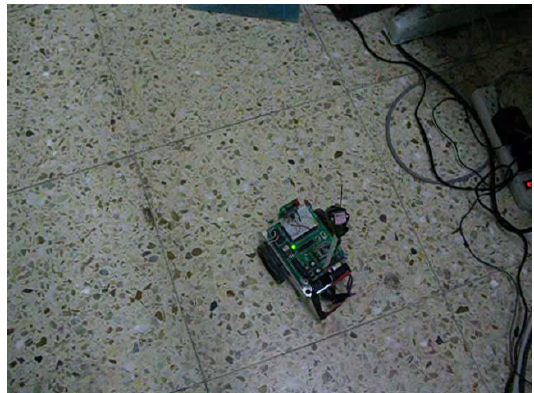
Figure 28. Initial position in the remote surveillance testing field.